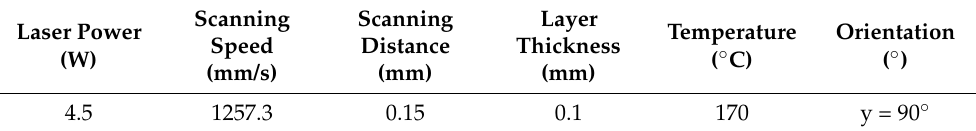
Table 5. Technological parameters used for manufacturing the acetabular liner by